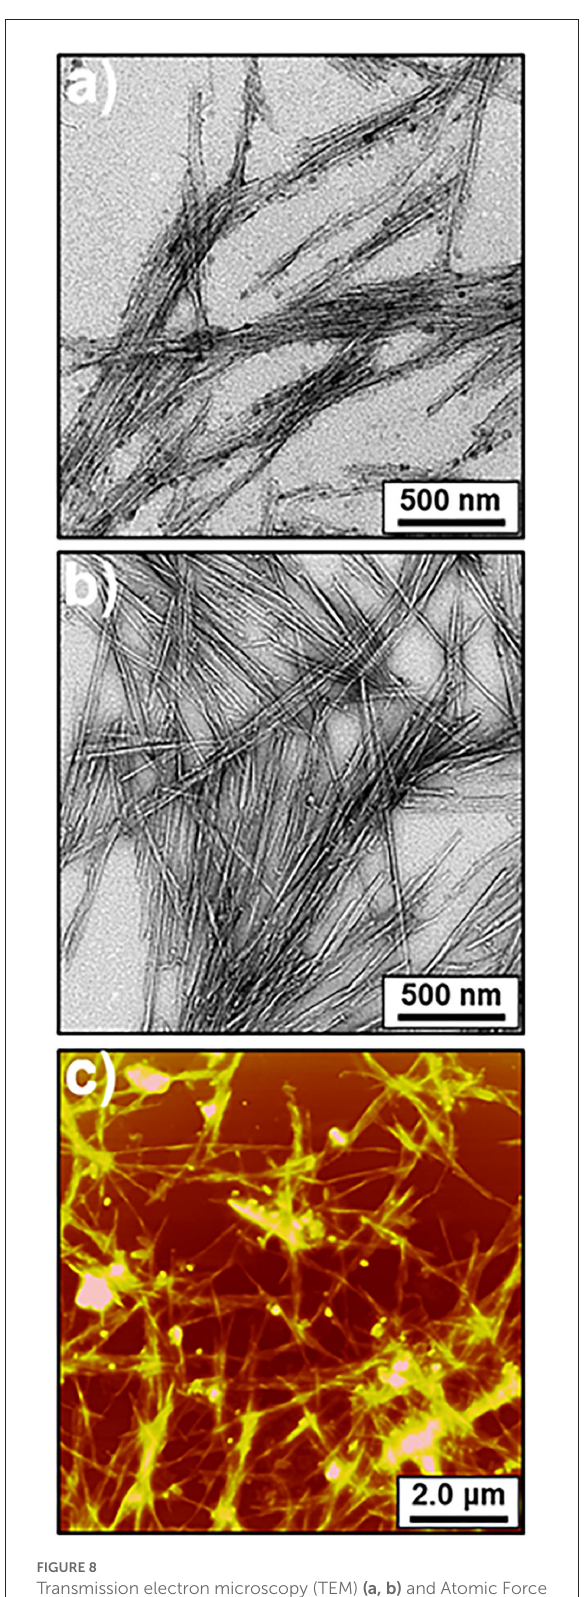
FIGURE8 Transmission electron microscopy (TEM) (a, b) and Atomic Force Microscopy (AFM) (c) images of BCNCs suspensions after hydrochloric acid (a, c) and sulfuric acid (b)